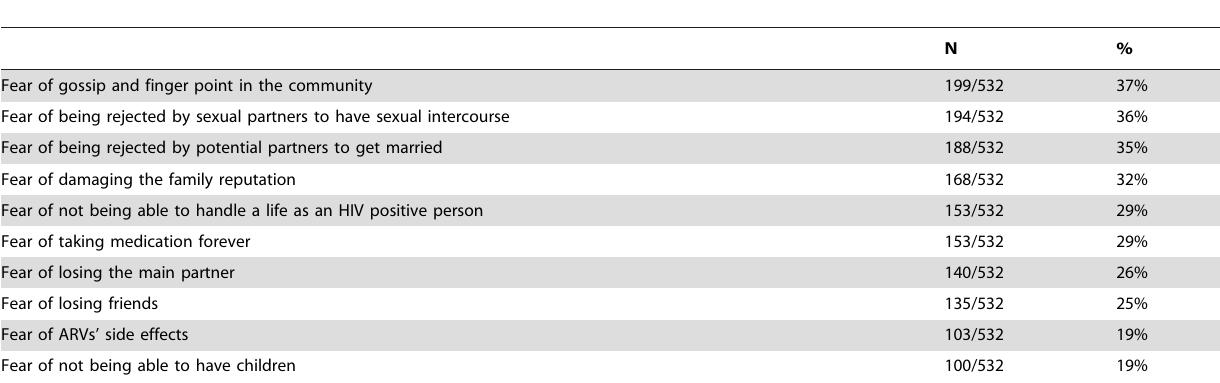
Table 3. Top 10 reasons for non-uptake of HIV testing among non-tested participants.